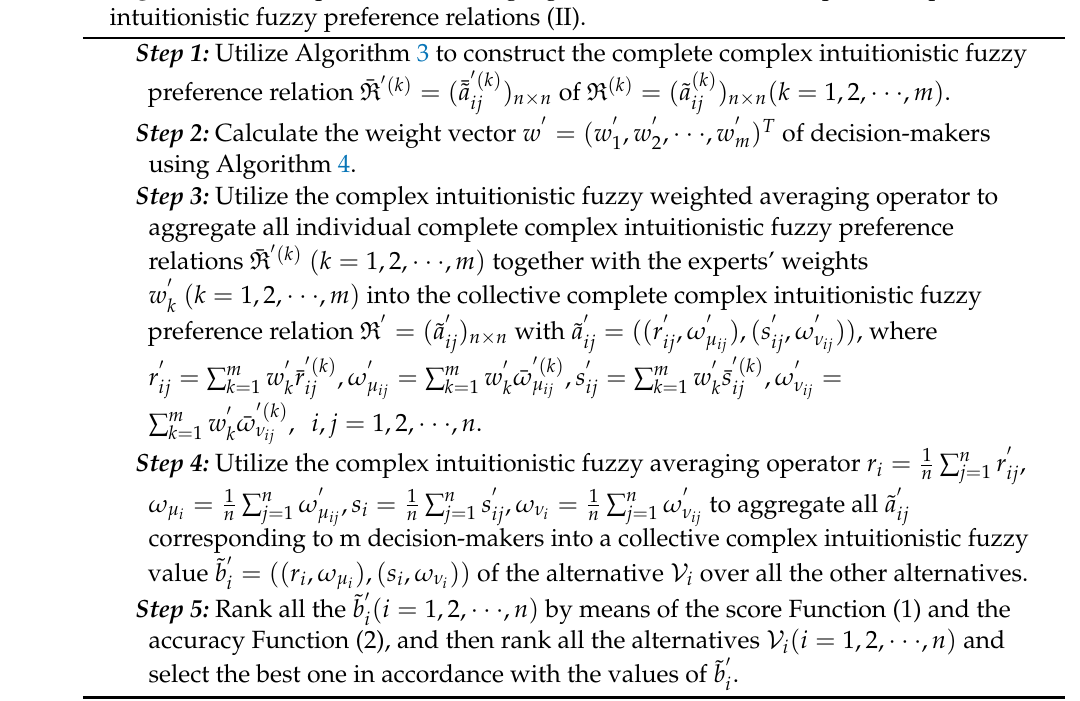
Algorithm 6: Group decision-making algorithms based on incomplete